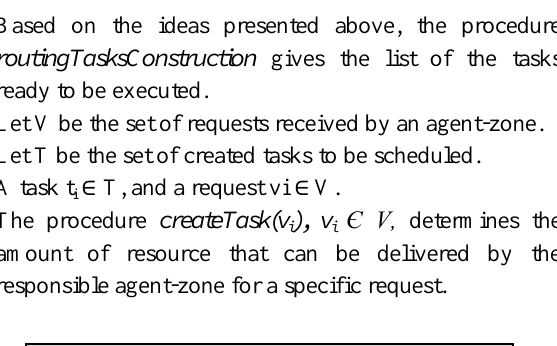
Fig. 3. The synchronized distributed scheduling